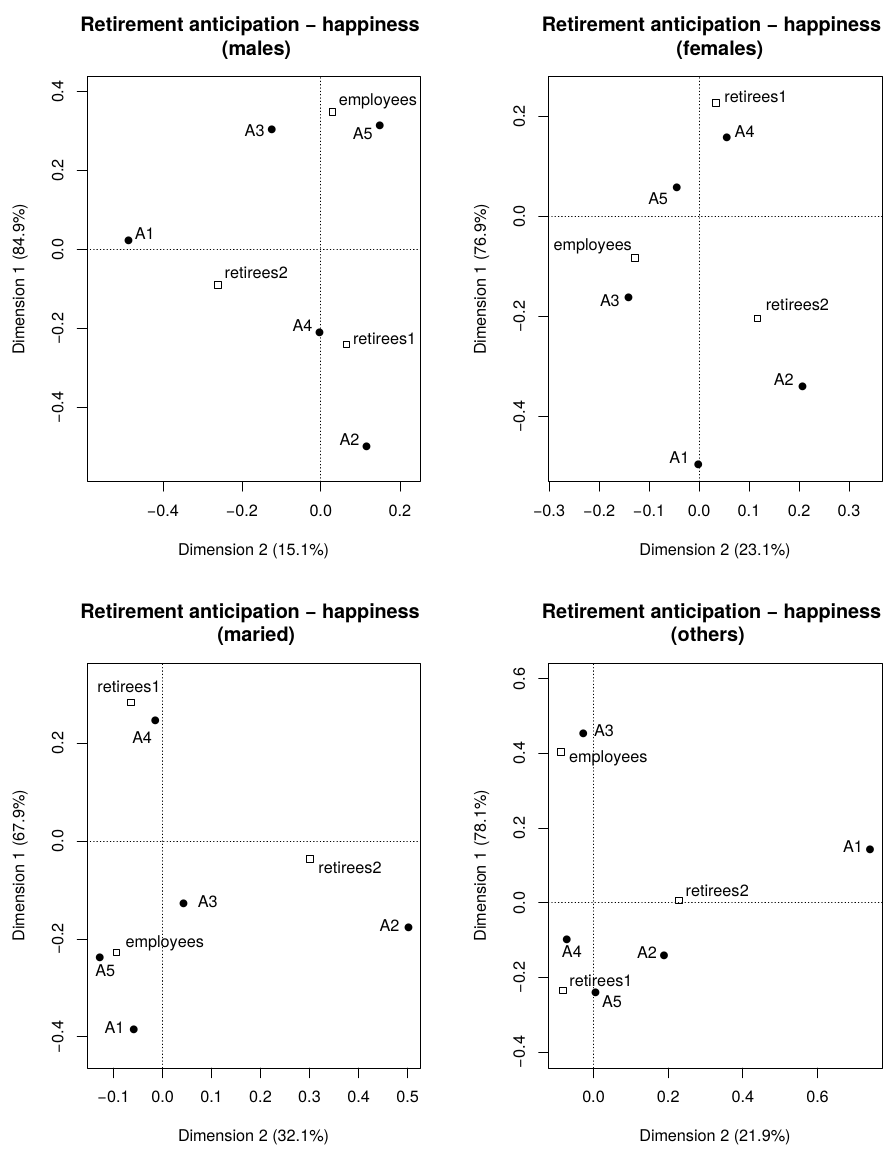
Figure 2. Classification maps (questions No. 15E and